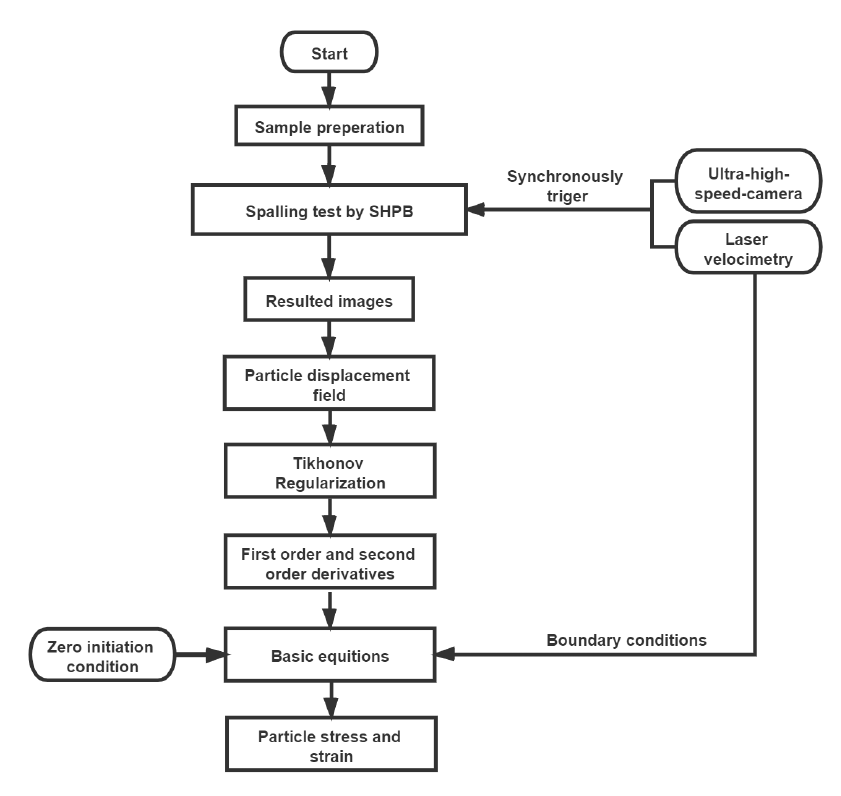
Figure 6. The flowchart of testing